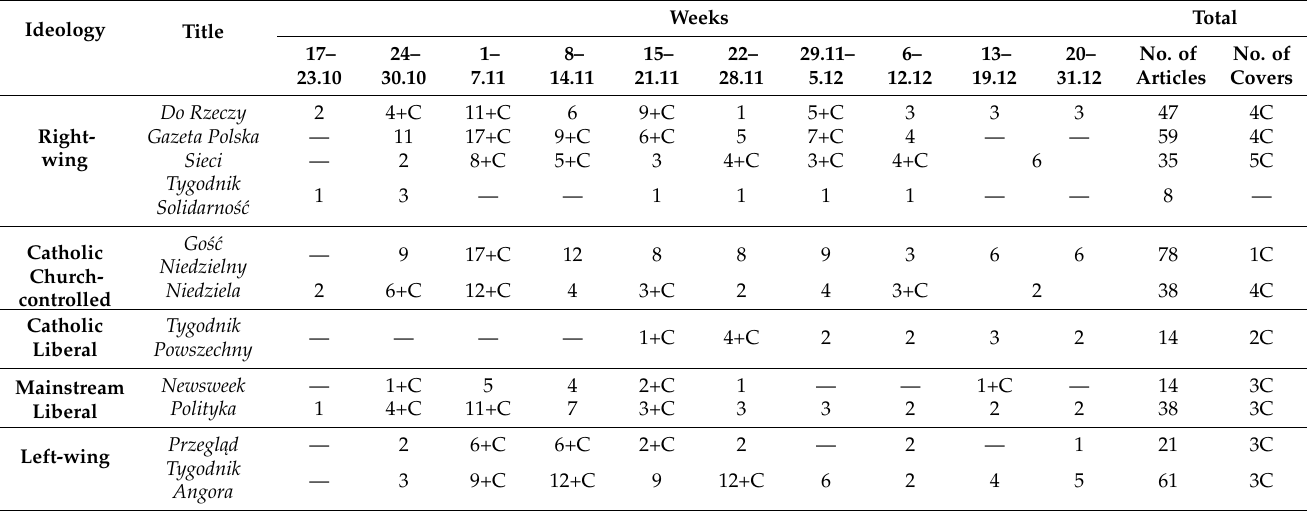
Table 1. The number of articles devoted to events that adversely impacted the Catholic Church in Poland by the selected opinion-forming weeklies between mid-October and 31 December 2020.